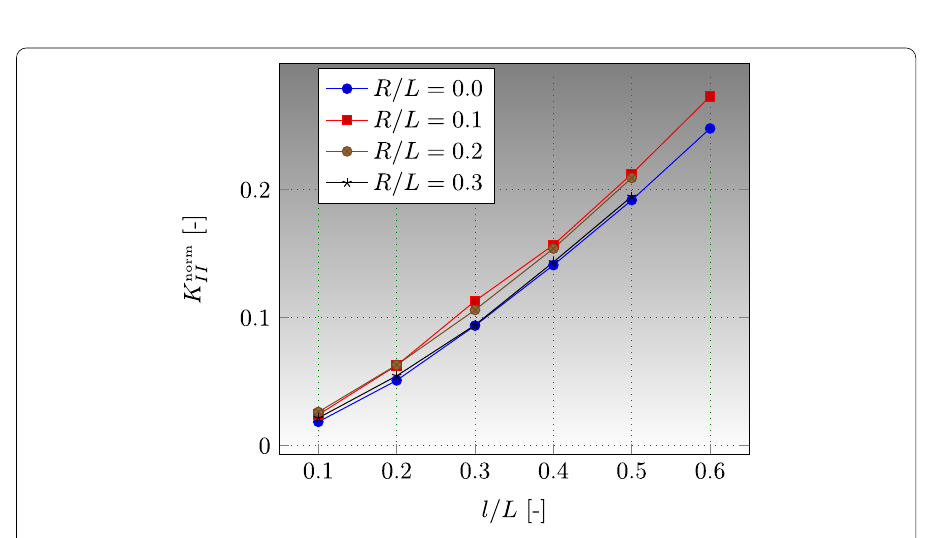
Fig. 12 Normalized SIFs for a square plate with round hole, various R / L and l / L